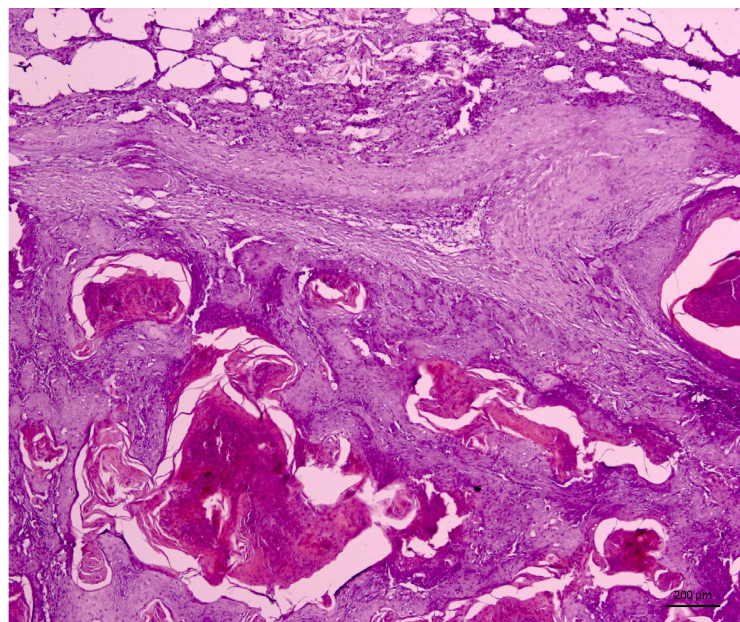
Figura 4. Fotomicrografia da metástase pulmonar do carcinoma de células escamosas da base do chifre em um bovino. Notar a marcada proliferação neoplásica sólida, sob a forma de ninhos e trabéculas, com grandes